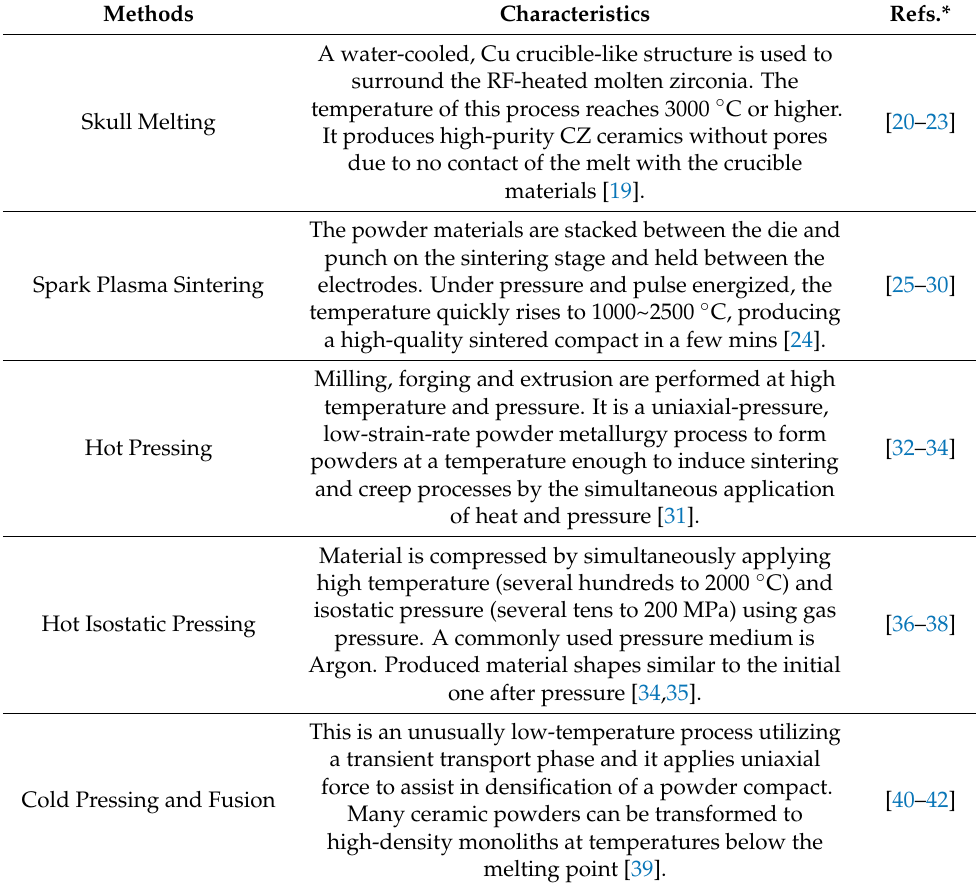
Table 1. Comparison of CZ production technologies along with relevant